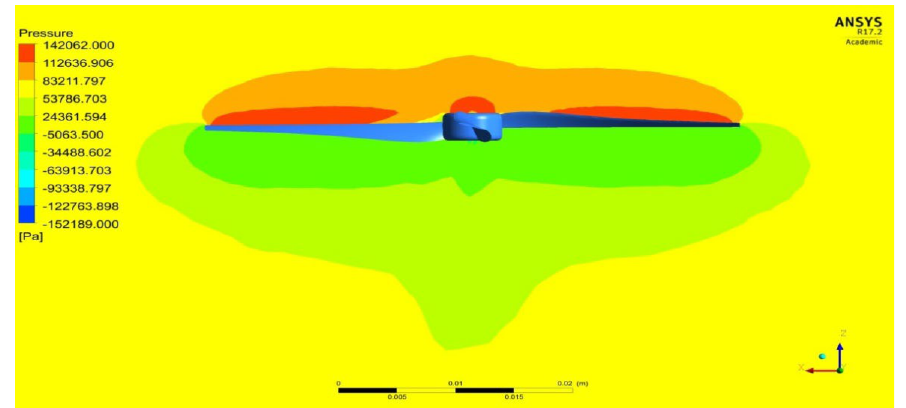
Figure 50. Hydrodynamic pressure variations over the UAV propeller under 800 RPM with wave celerity of 12.10 m/s.